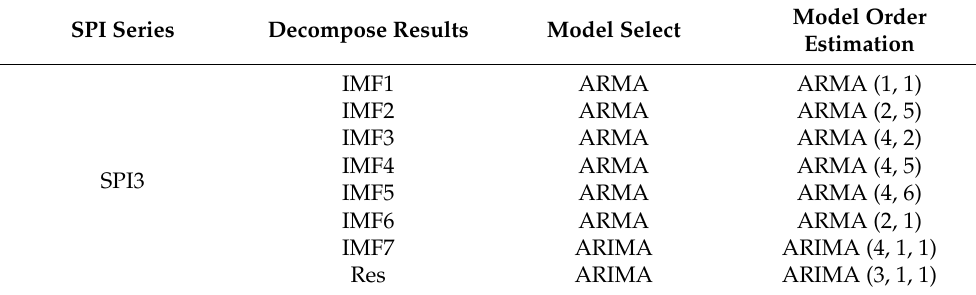
Table 5. Model order based on IMFs of the SPI3 sequence at Xiji